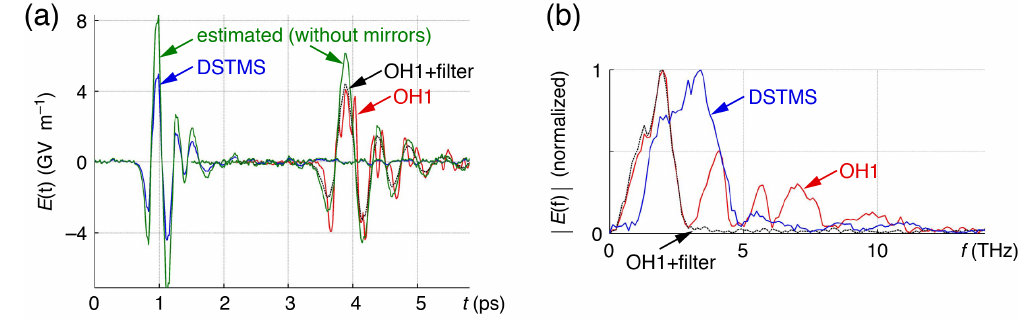
Figure 11. Intense THz-wave generation using a high-power Ti:Sapphire/optical parametric amplifier system (65 fs pulse duration, 100 Hz repetition rate) in DSTMS (0.44-mm thick, 1500 nm pump wavelength and 3.8 mJ pump energy, blue curves) and in OH1 (0.48-mm thick, 1350 nm pump wavelength and 3.5 mJ pump energy, red curves without and black dotted curves with a 3-THz low-pass filter): ( a ) THz time-domain signals detected by air-breakdown-coherent-detection and ( b ) the corresponding amplitude spectra. The green curves in ( a ) represent the estimated generated electric field E THz ( t ) considering the mirror losses, with a maximum of 8.3 GV/m for DSTMS and 6.2 GV/m for OH1 [94]. Reprinted from Ref. [94] with permission from Springer